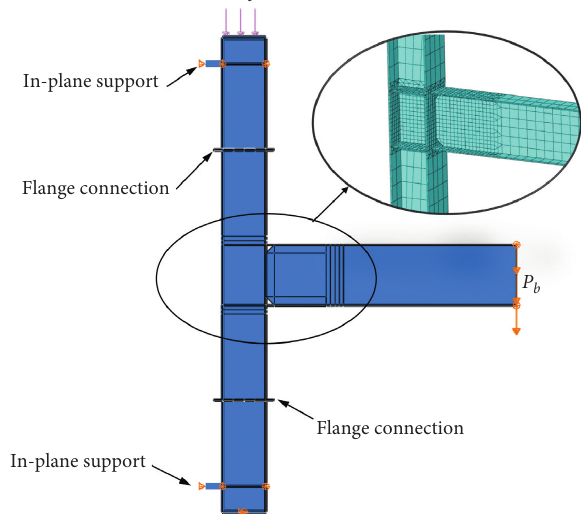
Figure 3: The shell element model.